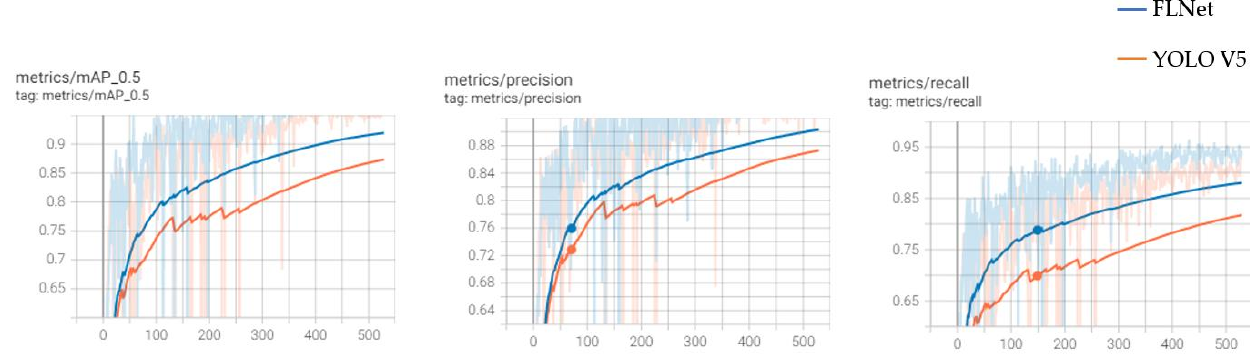
Table 3. Experimental results on HRSID